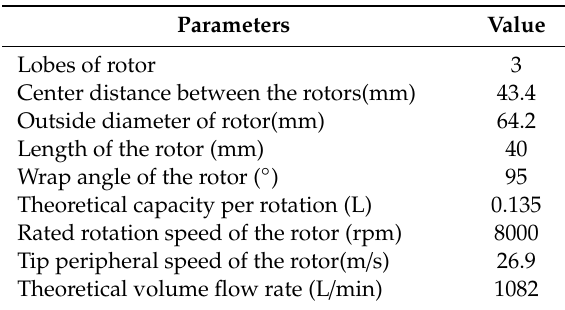
Table 2. Technical parameters of the Roots